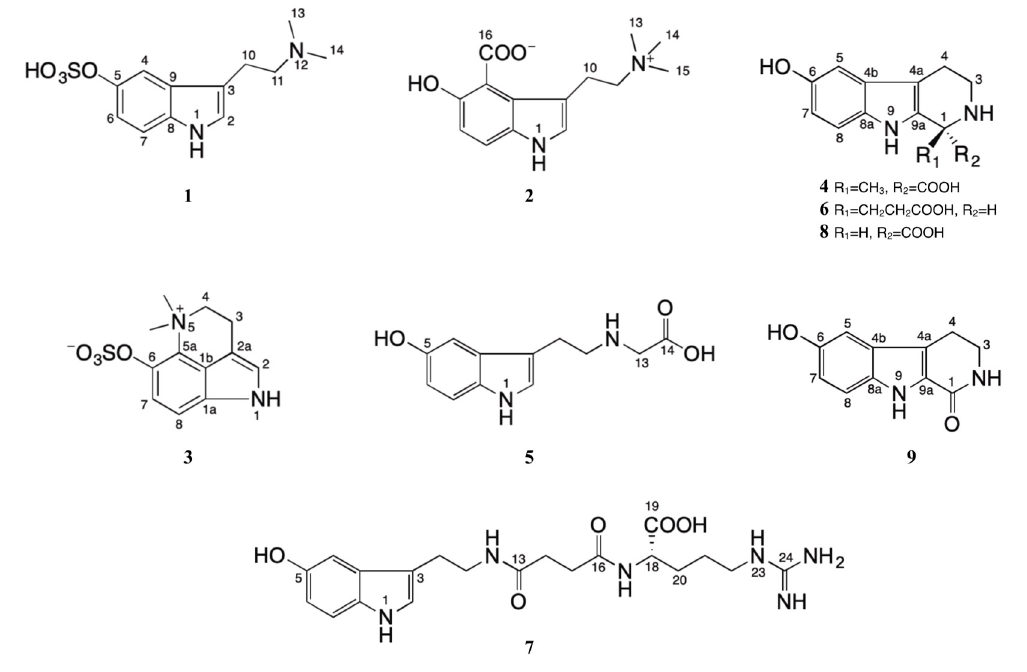
Figure 1. Chemical structures of compounds 1–9.